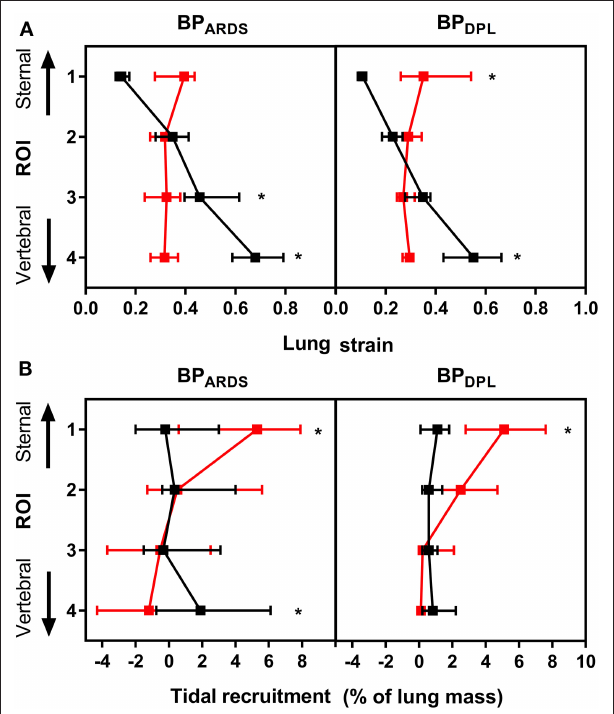
FIGURE 3 | CT-derived regional strain (A) and tidal recruitment (B) in supine (black dots) and prone (red dots) positions with PEEP set according to BP ARDS (left panels) and BP DPL (right panels). Data plotted as median (25–75th percentile). *Significant difference in the same ROI in prone vs. supine with p < 0.05. CT, computed tomography; ROI, region of interest.